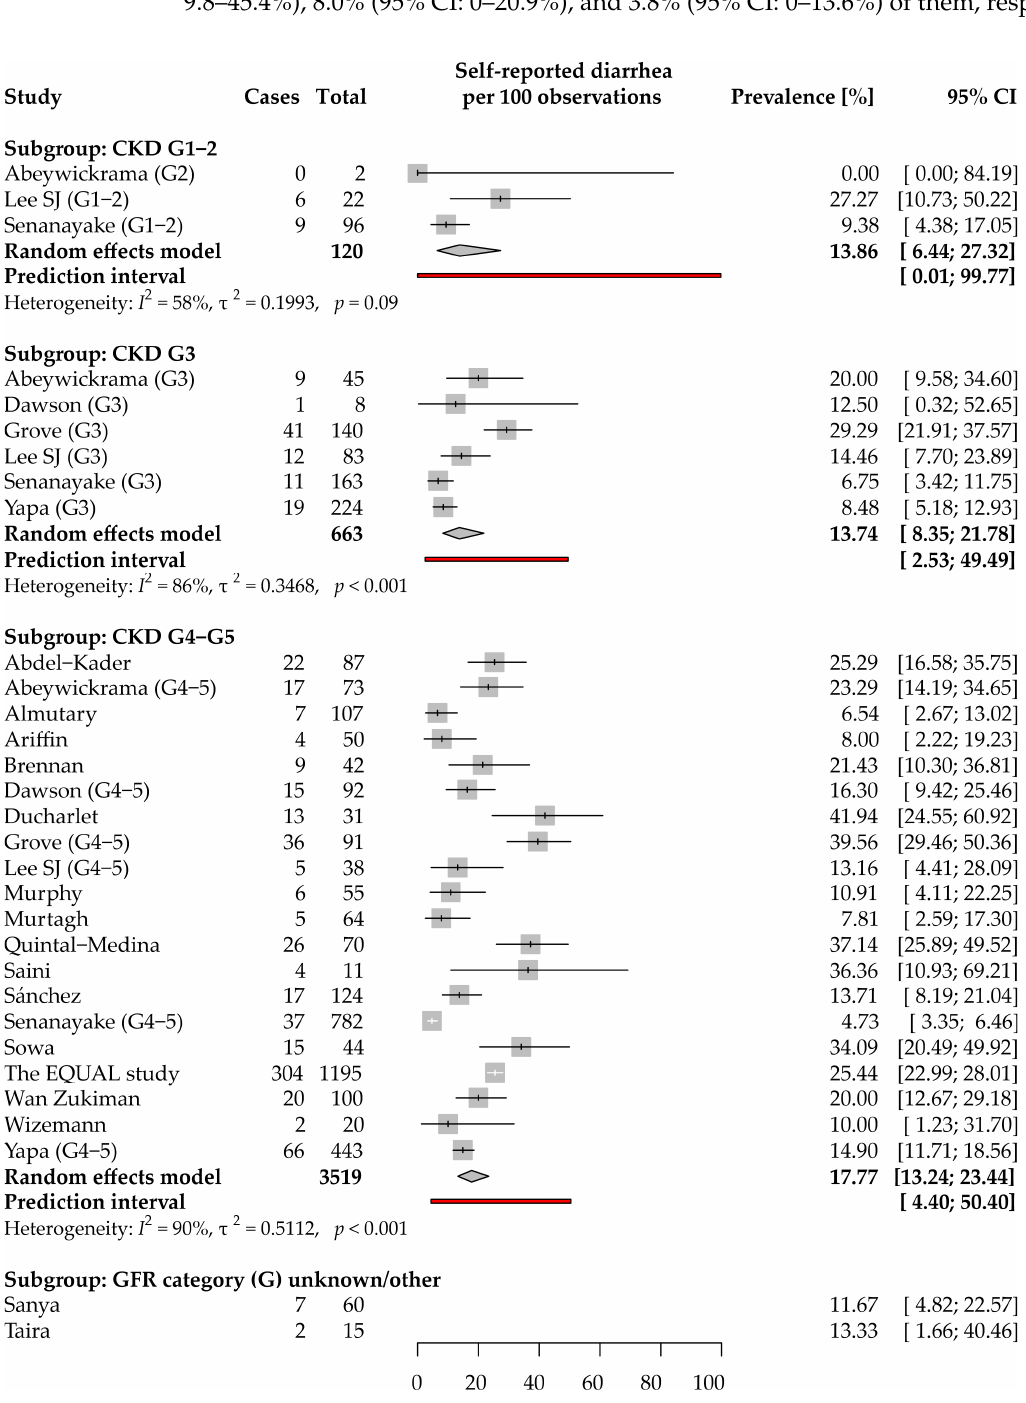
Figure 4. Forest plot with pooled point prevalence estimates for self ‐ reported diarrhea in chronic kidney disease by stages.